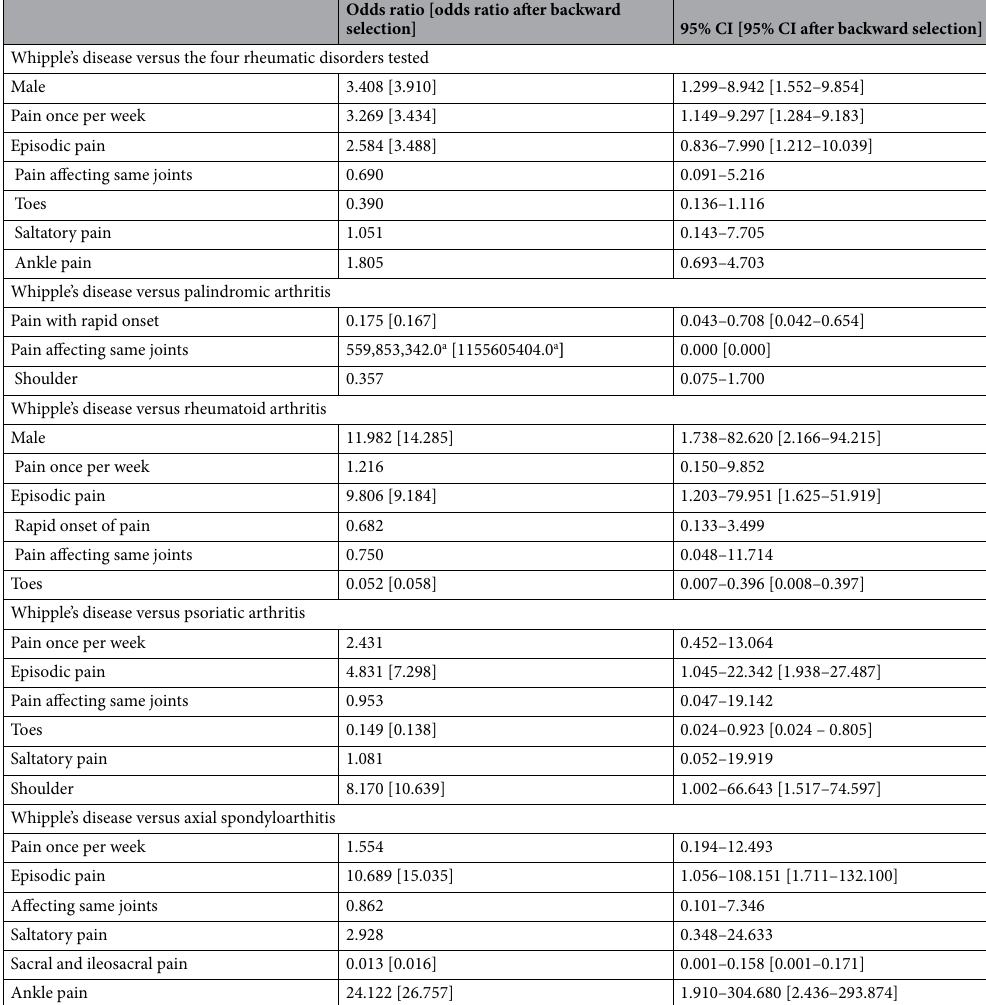
Table 4. Multiple logistic regression analysis of symptoms in 40 patients with Whipple’s disease versus patients with palindromic arthritis, rheumatoid arthritis, psoriatic arthritis, and axial spondyloarthritis. Values greater than 1.0 suggest a constellation of symptoms favoring Whipple’s disease, lower values are indicative for one of the other disorders. a There was no patient in the palindromatic group in whom the same joints were affected in the following